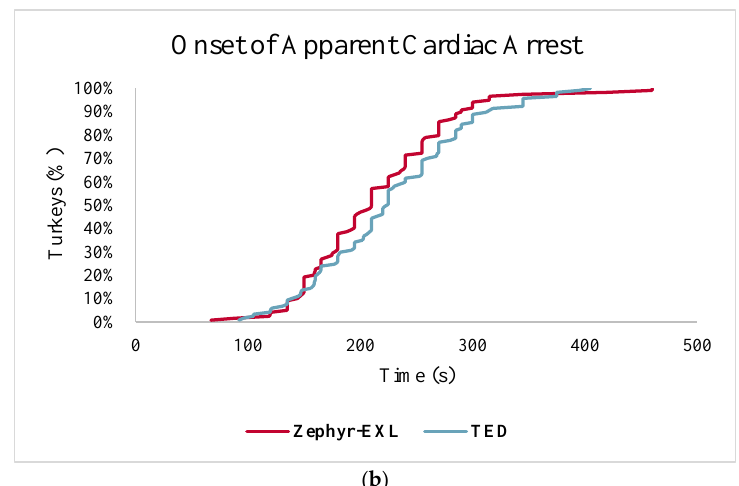
Figure 4. Cumulative frequency distribution for ( a ) time to last movement (s) and ( b ) time of apparent cardiac arrest (s) for turkeys killed with Zephyr-EXL or TED. Time point 0 indicates the time of application of the device.